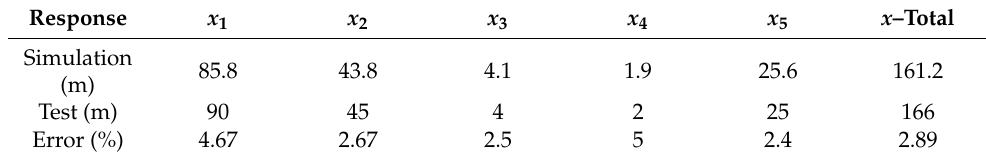
Table 3. Displacement comparison of each process of experiment and simulation.